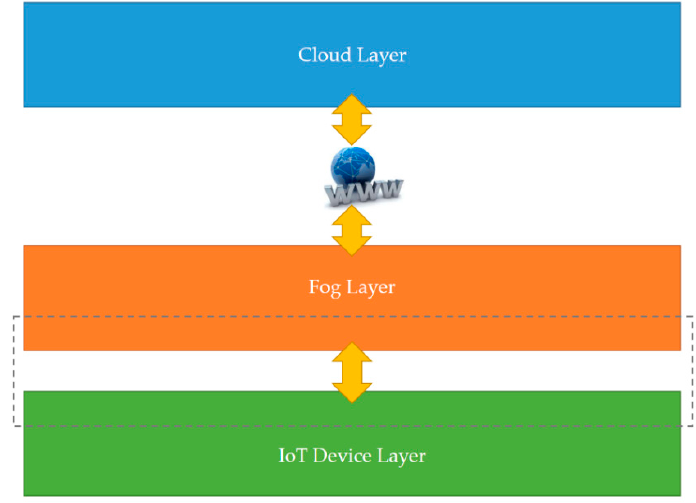
Figure 1. Generic three-tier architecture of fog-cloud analytics. IoT = Internet of Things.